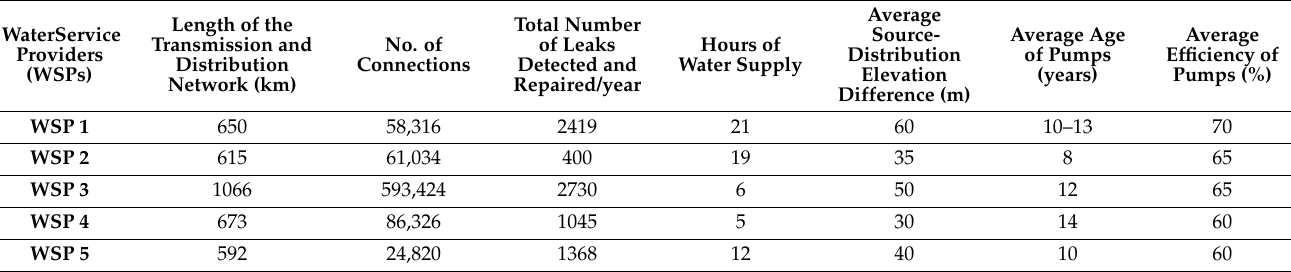
Table 3. Water supply network characteristics of selected WSPs as at